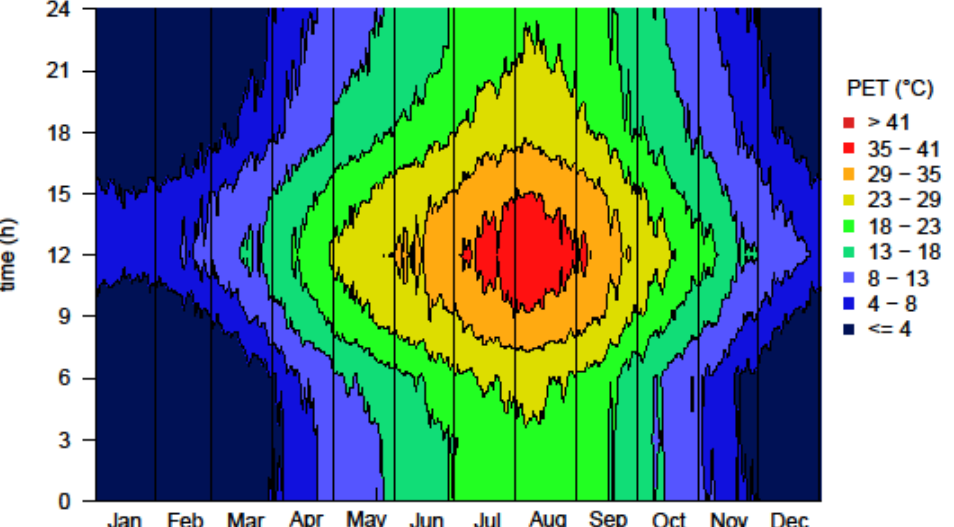
Figure 7. Temporal diagram for PET for Tokyo during the period August 1966 to June 2018 (3 h resolution). The reference height for the results is 1.1 m. The sensation classes are defined in Table 2. The variation throughout the day can be seen in y-direction, while the variation over the year is given in x-direction.